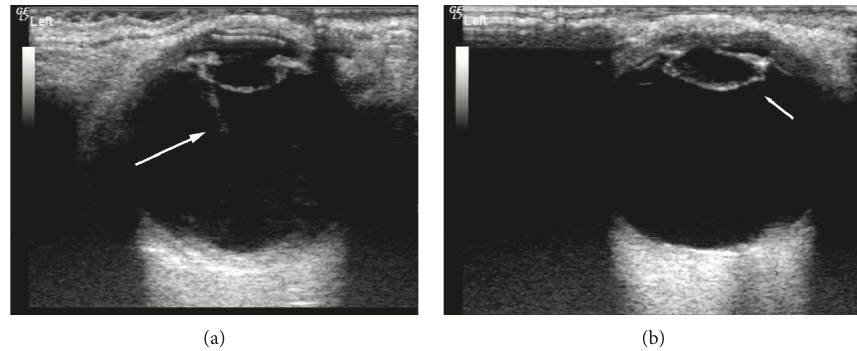
Figure 3: False-positive image of PC by 14MHz +THI. (a) The shape of the lens is regular, the internal echo is uniform, and the PC echo is regular. A moderate echo band is shown and was mistaken for a passage (long arrow). (b) The shape of the lens is not regular, the internal echo is not uniform, the anterior capsule is ruptured, and the PC of the equator shows a sharp echo, which was mistaken for rupture (short